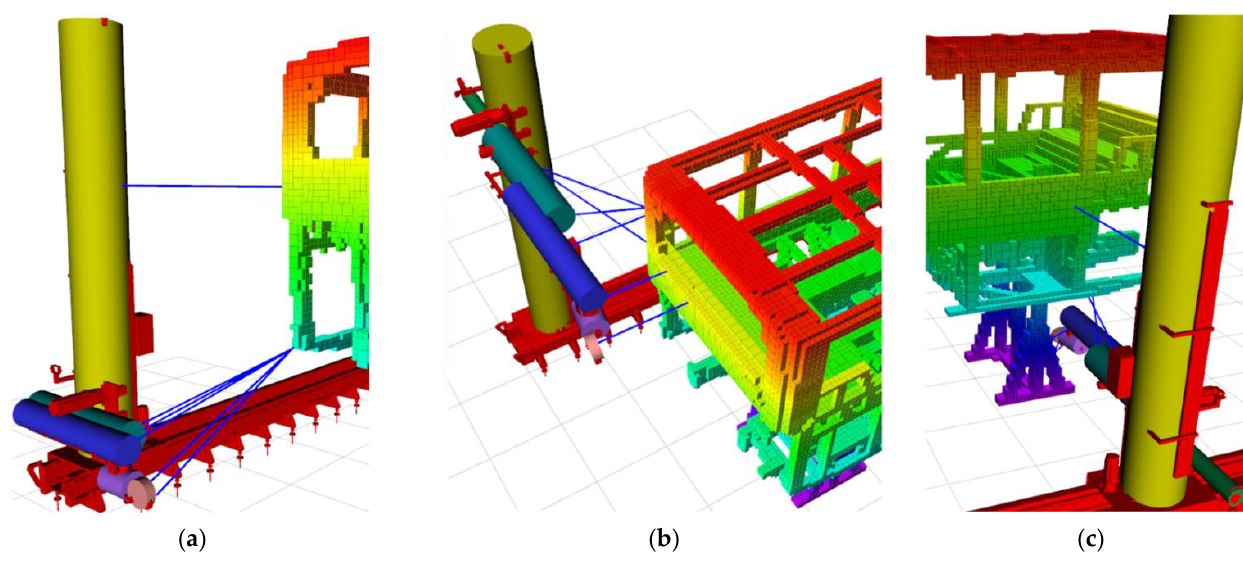
Figure 16. Visualization of the minimum distances of cylinders with blue lines at ( a ) 0 s, ( b ) 60 s, and ( c ) 110 s.